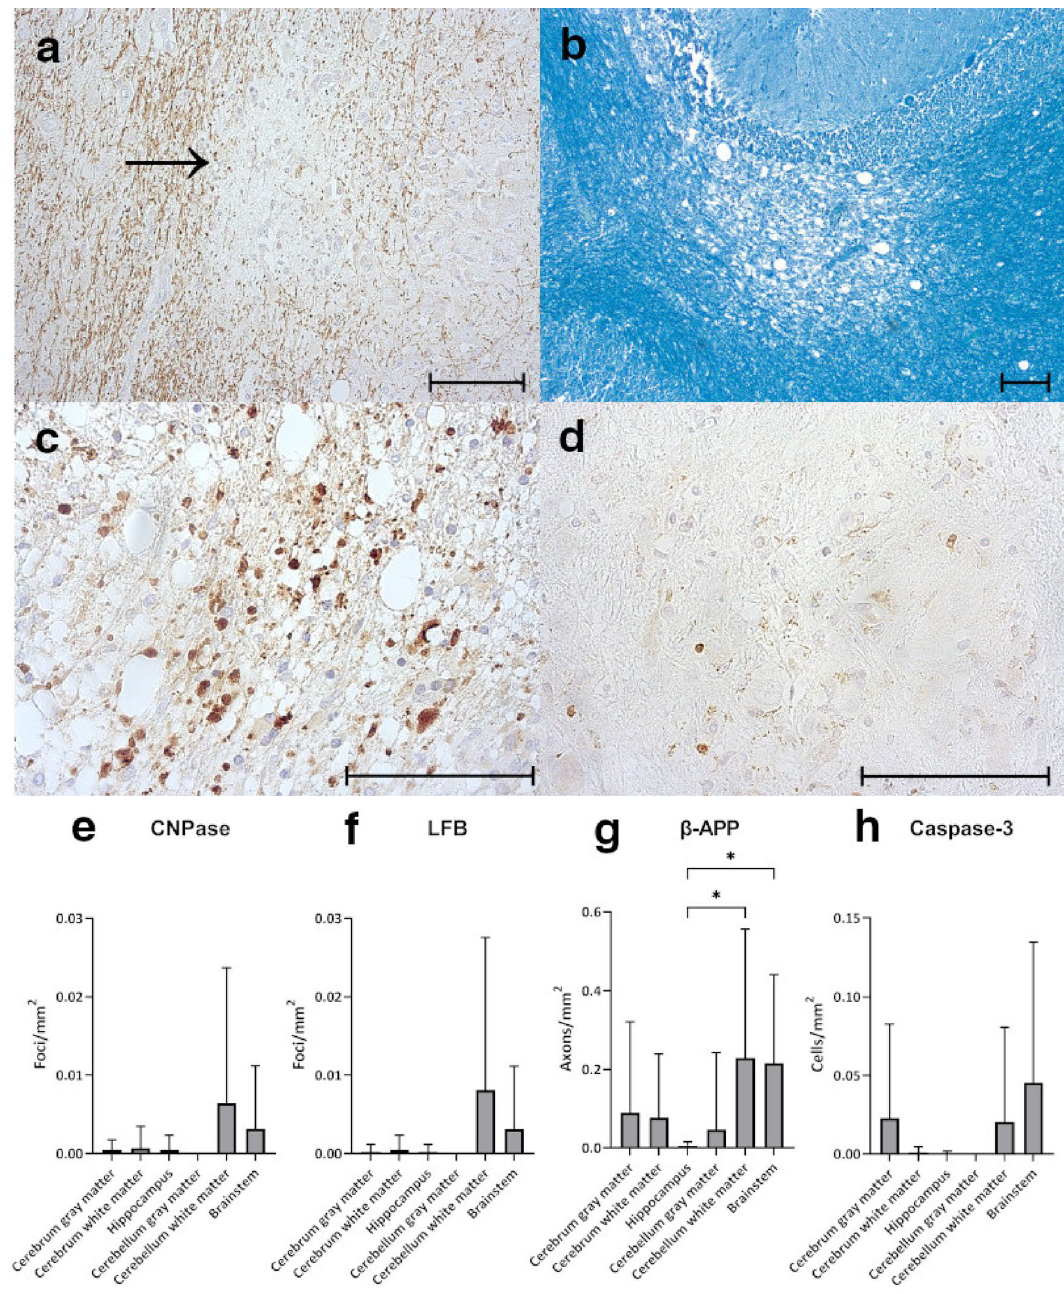
Figure 5. Identification of demyelination, axonal damage and apoptotic cells in infected foxes. ( a ) Lack of CNPase staining (arrow), cerebrum. ( b ) Lack of Luxol fast blue (LFB) staining, cerebellum. ( c ) β-APP + damaged axons within demyelinating lesion, cerebellum. ( d ) Cleaved caspase-3 + apoptotic cells, cerebrum. ( e ) Quantification of foci lacking CNPase staining (CNPase-negative foci) within different brain regions. ( f ) Quantification of foci lacking LFB straining (LFB-negative foci) within different brain regions. ( g ) Quantification of β-APP + axons within different brain regions. ( h ) Quantification of cleaved caspase-3 + apoptotic cells within different brain regions. ( e – h ) Bars display mean values and standard deviations. Asterisks indicate statistical significance levels, * ≤ 0.05. Scale bars = 100 sites (e.g. aa 525-529 and 552) appeared to be conserved 65,66 . Although fox CDV strains were found to differ with respect to affiliation to specific subclades with the Europe-1/South American-1 lineage and showed some varia- tion in the receptor-binding domain of the H protein, no differences in neuropathology between foxes could be linked to specific virus molecular determinants.